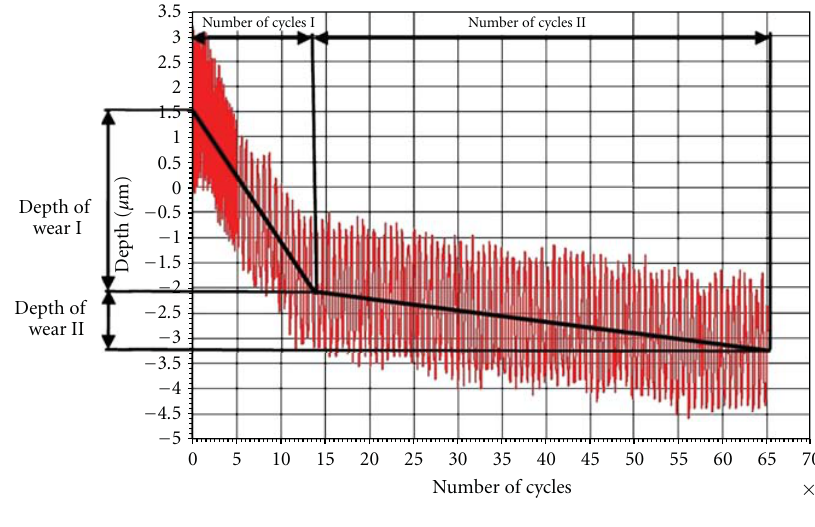
Figure 4: Two phases of wear.